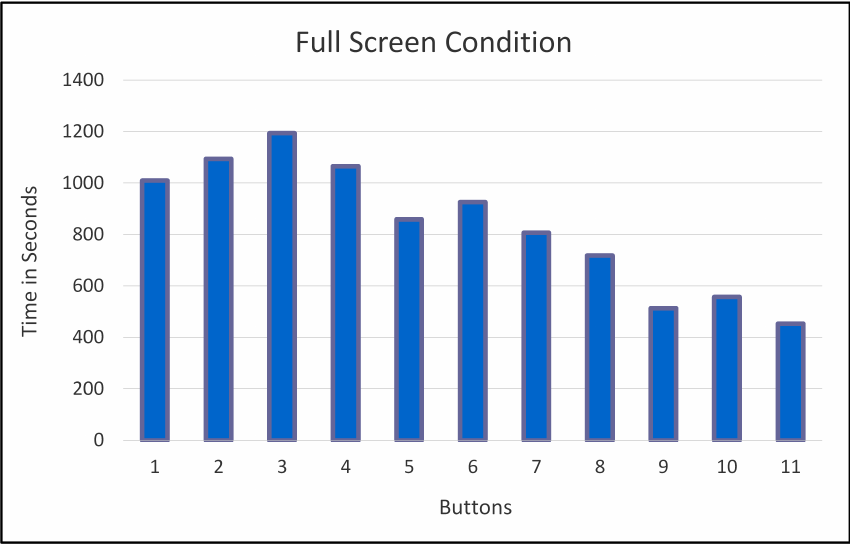
Figure 8. Line graph of time spent on each page in case of full screen